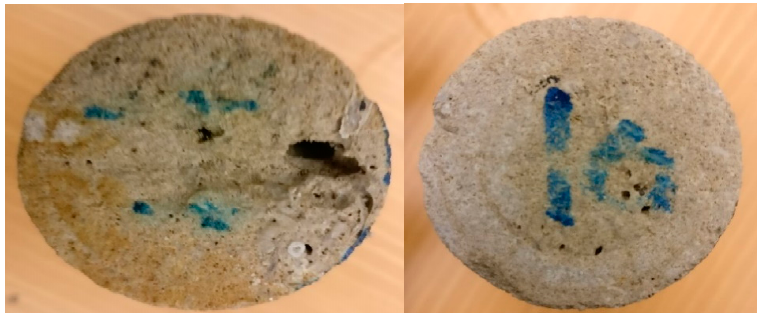
Figure 9. Profiles of pressure-drop across the low-permeability (10 mD) and high-permeability (100 mD) rocks during the alternating injection of thermochemical and HCl fluids.